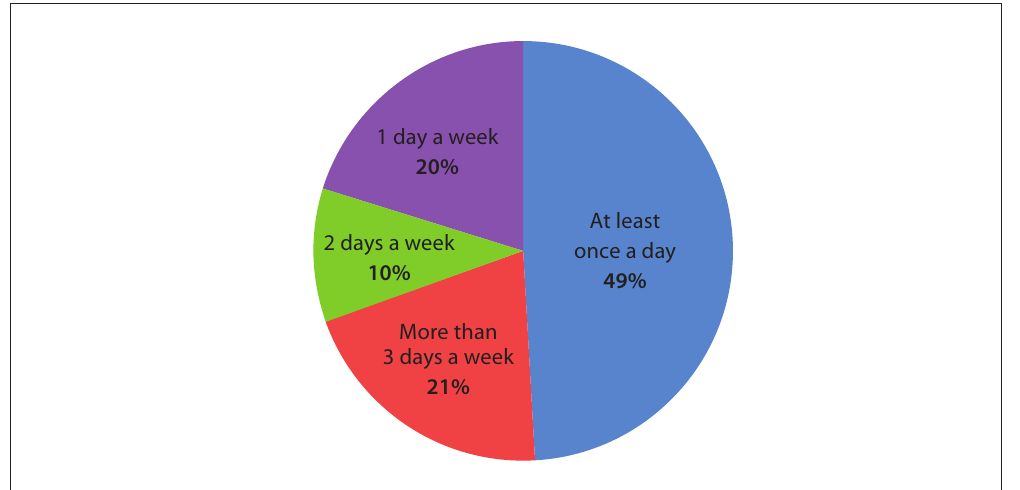
Figure 2 Frequency of logins into Facebook